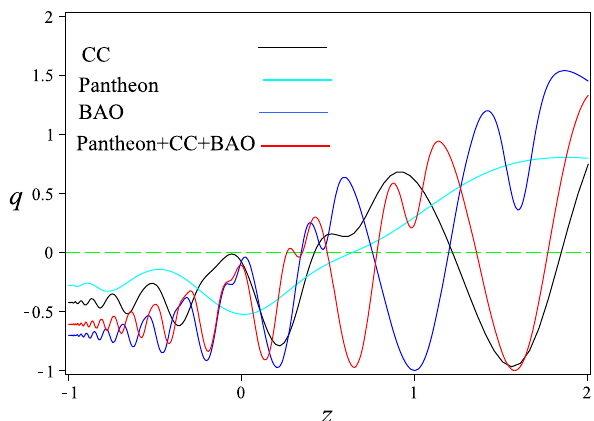
Fig. 4 The plot of deceleration parameters q for the best-fitted values of parameters of (α,β) using different dataset